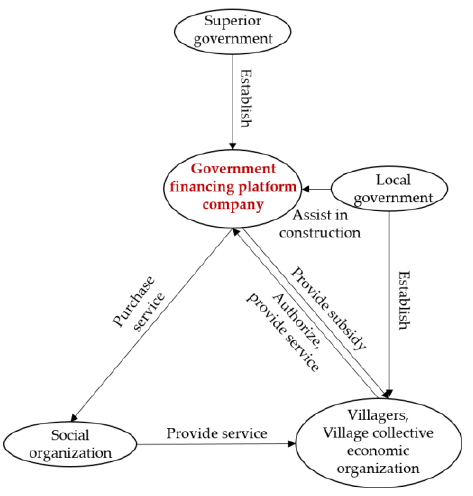
Figure 9. Construction and operation relationship of multiple entities of Qianjiadu.